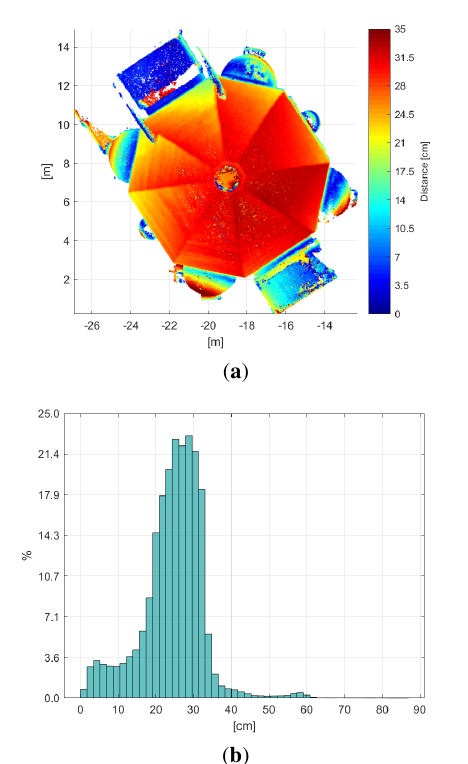
Figure 8. Photogrammetric 3D model of Savonarola gate (with UWB anchor self-positioning) accuracy assessment: comparison with the TLS 3D model. Point clouds registered in local coordi- nates with the ICP algorithm. ( a ) Map of point-to-point distances. ( b ) Histogram of distances shown in ( a